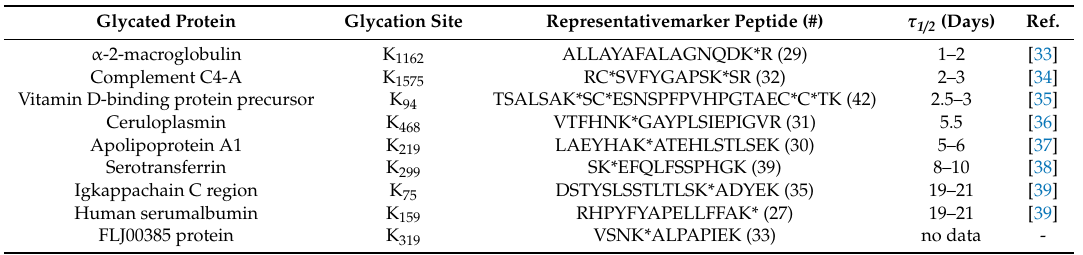
Figure 3. Tandem mass spectra acquired at m / z 673.66 ( A ) and 463.56 ( B ) corresponding to the [M + 3H] 3 + ions of the peptides, EQLK Am AVM ox DDFAAFVEK and FK Am DLGEENFK (both human serum albumin). The spectra were acquired with the LTQ-Orbitrap Velos Pro mass spectrometer operated in the positive ion mode as a part of targeted RP-HPLC-Orbitrap-LIT-MS / MS DDA workflow. The inserts represent extracted ion chromatograms ( m / z ± 0.02) acquired for the m / z 673.66 ( A ) and 463.56 ( B ). K Am and M Ox denote glycated lysyl and oxidized methionyl residues, respectively. Table 2. The half-life times of plasma proteins, containing specific glycation sites differentially abundant in T2DM patients and normoglycemic individuals.